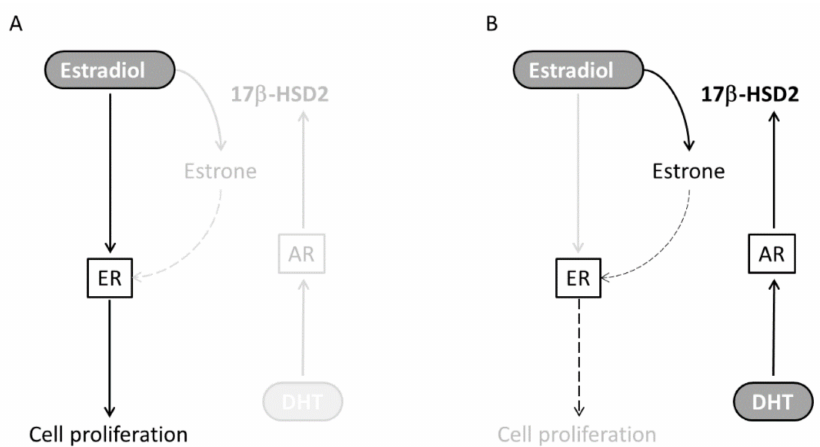
Figure 6. ( A ) In endometrial cancer cells, estradiol promotes cancer cell proliferation through binding to estrogen receptors (ER). ( B ) Androgen [dihydrotestosterone (DHT)] induces 17 β -HSD2 expression through binding to androgen receptors (AR). When estradiol is converted into the weaker estrone, by 17 β -HSD2, the cell proliferative activity of ER signal is